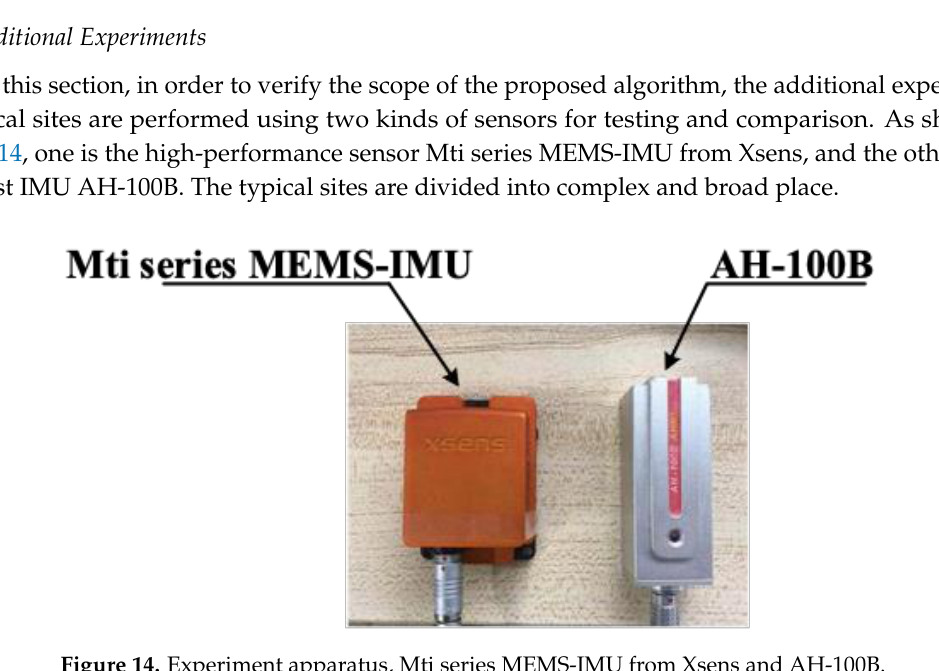
Figure 14. Experiment apparatus, Mti series MEMS-IMU from Xsens and AH-100B.